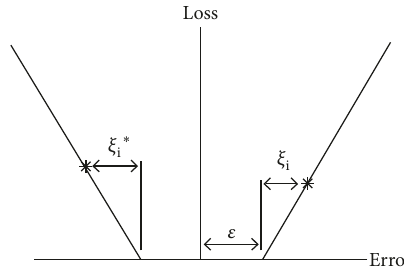
Figure 1: 𝜀 -insensitive loss